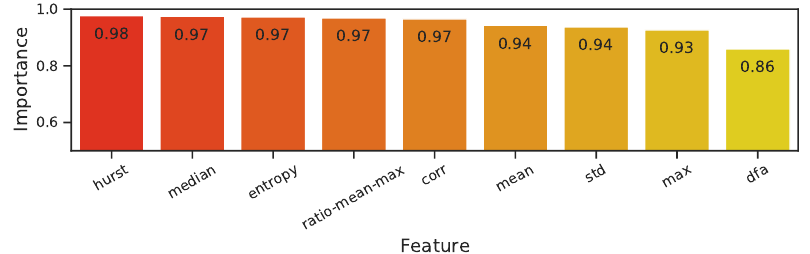
Figure 11. Feature importance computed using SPEC. The highest values reveal the most impor- tant